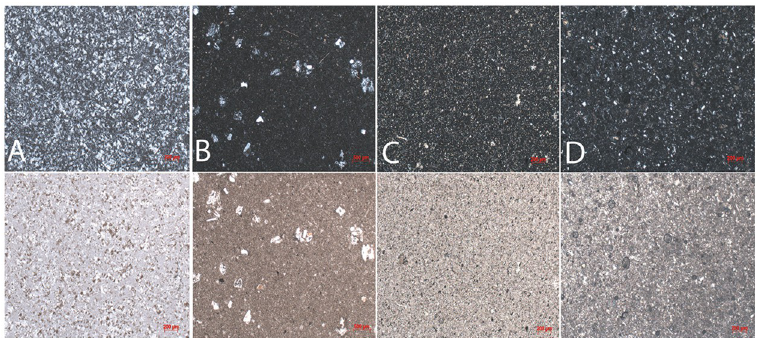
Fig 7. Photomicrographs of A) chert, B) calcareous shale, C-D) and siliceous shale under XPL (upper) and PPL (lower) lights.